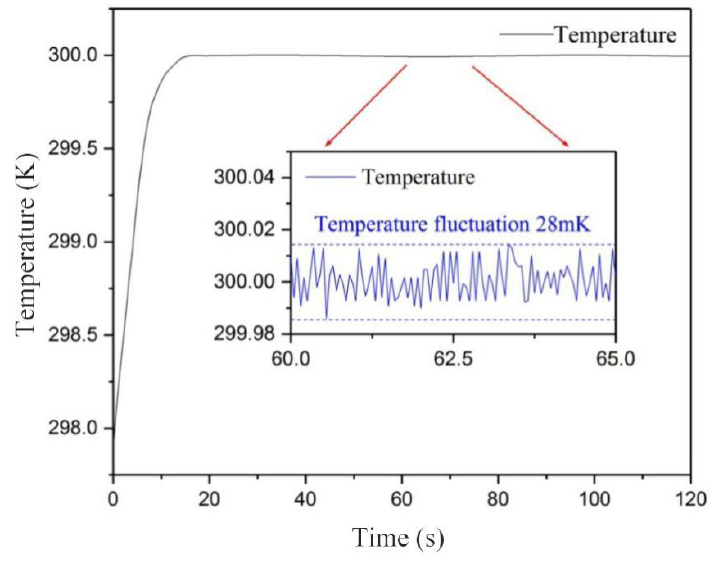
Figure 4. The experimental results of the MPGC working temperature with 120 s of control time; the temperature fluctuation results are inserted.